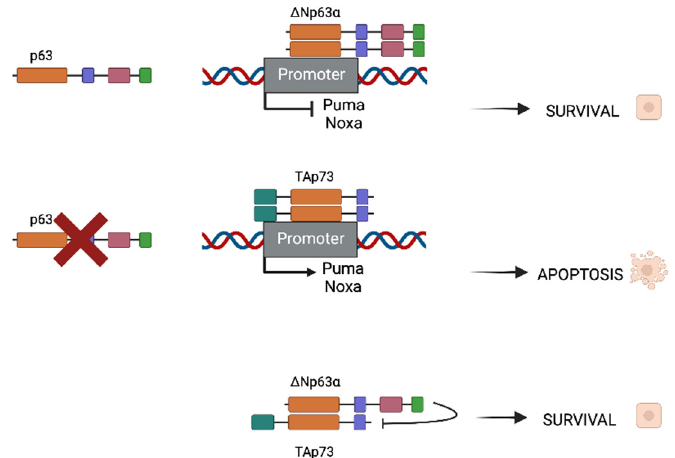
Figure 2. Different oligomerization of Δ Np63 α and TAp73 depending on p63 presence or absence. When Δ Np63 α is present in cancer cells, survival will be induced. In contrast, when p63 is not present, homodimers of TAp73 will be formed and will promote pro-apoptotic gene expression (Puma and Noxa for instance). In HNSCC, both Δ Np63 α and TAp73 are expressed but TID of Δ Np63 α is capable of inhibiting pro-apoptotic function of the TA isoform, thus promoting survival and cancer progression.